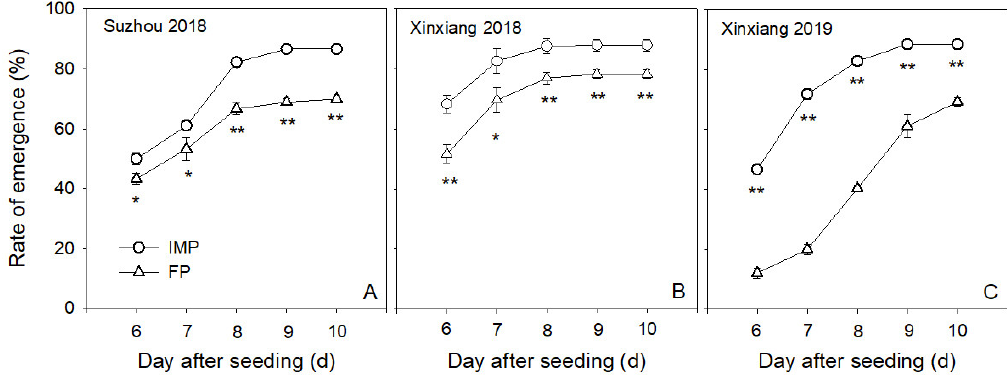
Figure 4. The effects of seeding management practices on the rate of emergence for soybean. IMP, integrated management practice; FP, farmers’ practice. * and **, indicate significance different at the 0.05 and 0.01 probability levels, respectively. The bottom and top bars of each dataset represent standard error. ( A ) represents the rate of emergence at Suzhou site in 2018. ( B ) and ( C ) represent the rate of emergence at Xinxiang site in 2018 and 2019, respectively.